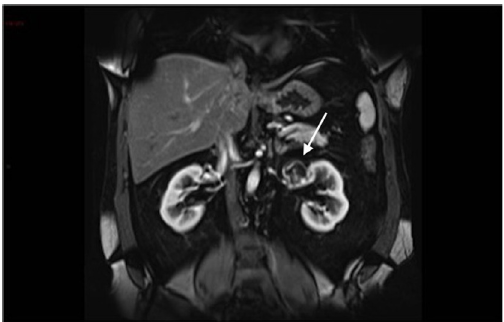
Figure 4 - Coronal T1 post-contrast arterial phase imaging showing peripheral enhancement (arrow).